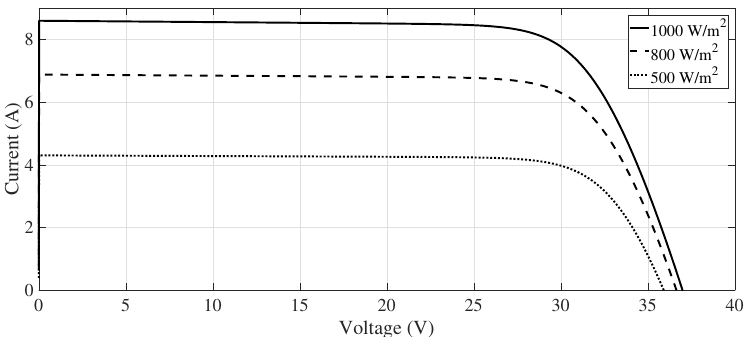
Figure 4. P-V curve for PV module 1Soltech 1STH-240-WH.